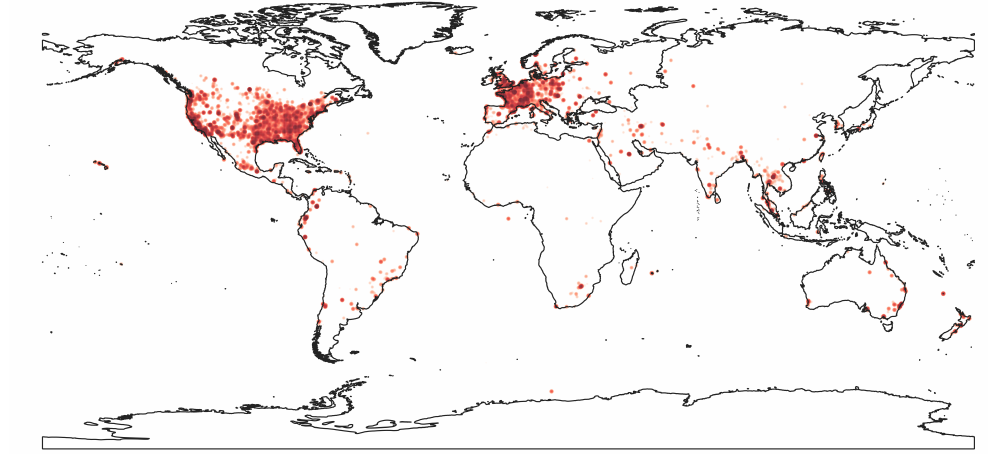
Figure 16. ‘Heatmap’ representation of the NoiseCapture data collected around the